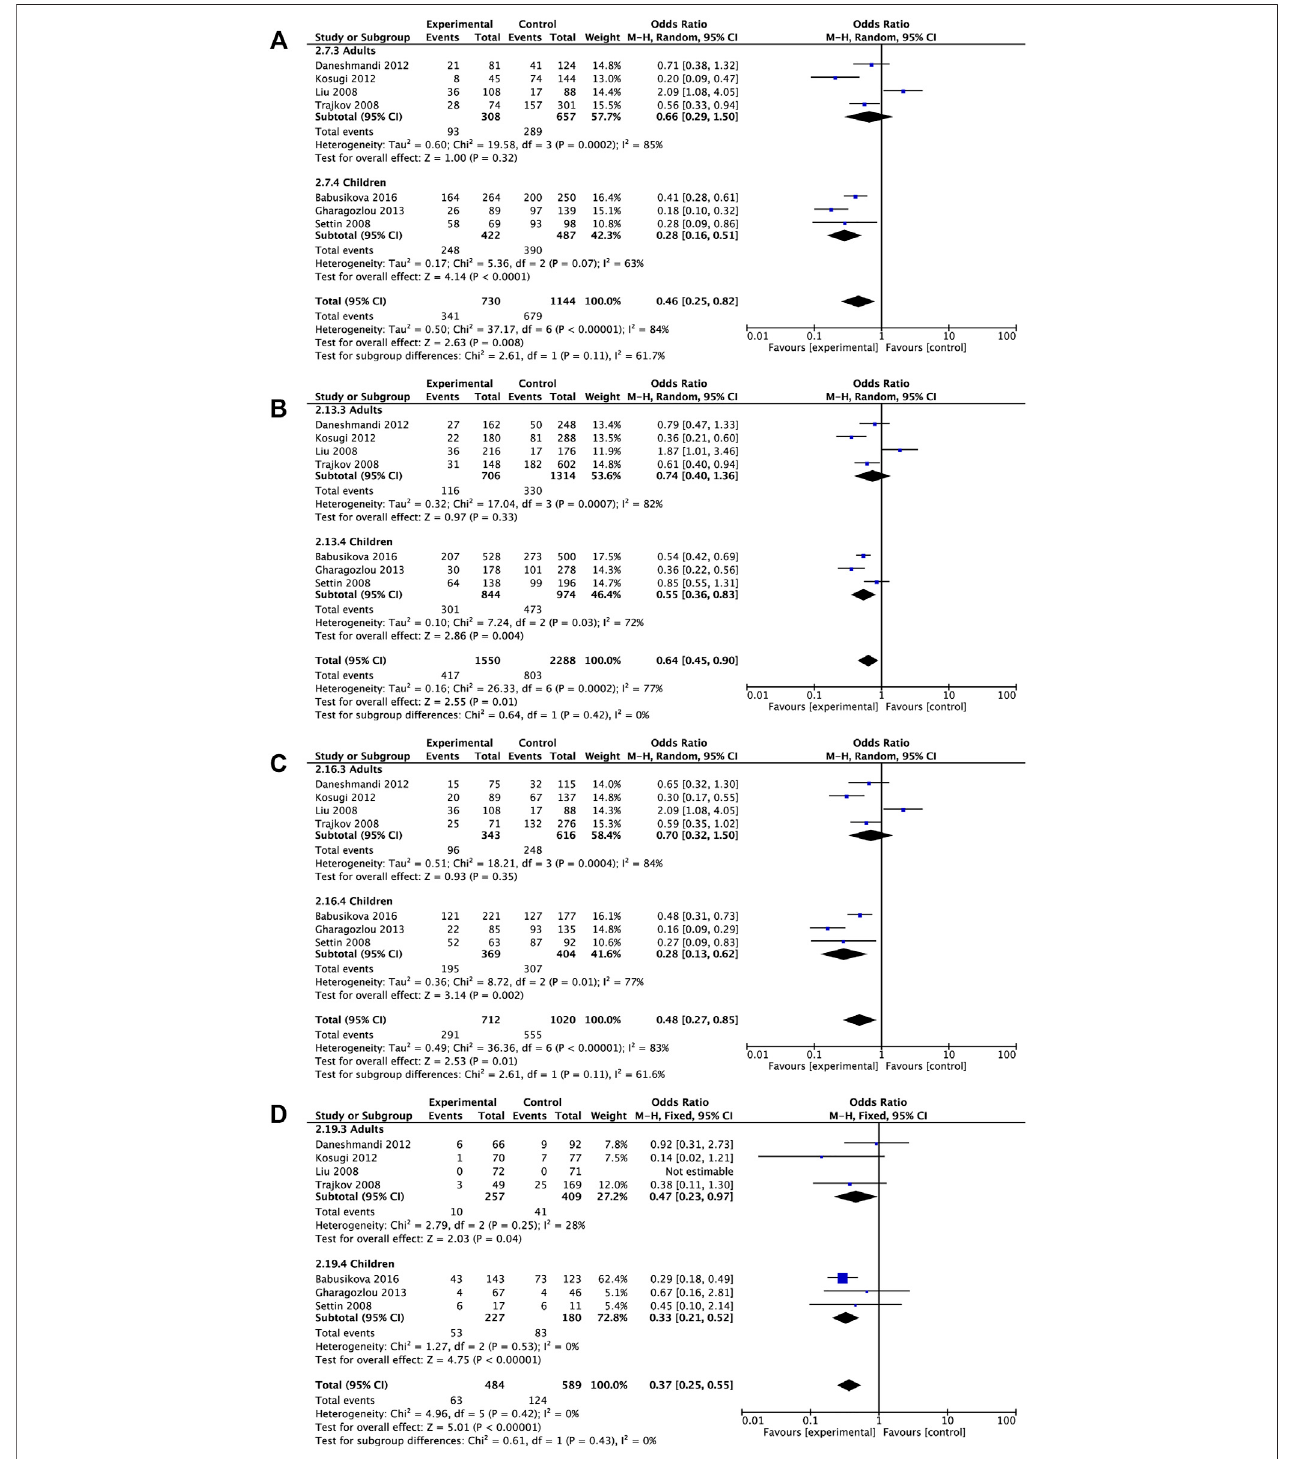
FIGURE 3 | Pooled OR and 95% CI of individual studies and pooled data for the association between IL6 rs1800795 polymorphism and overall allergic diseases risk in different age subgroups for (A) dominant comparison, (B) allele comparison, (C) heterozygote comparison, and (D) homozygote comparison.